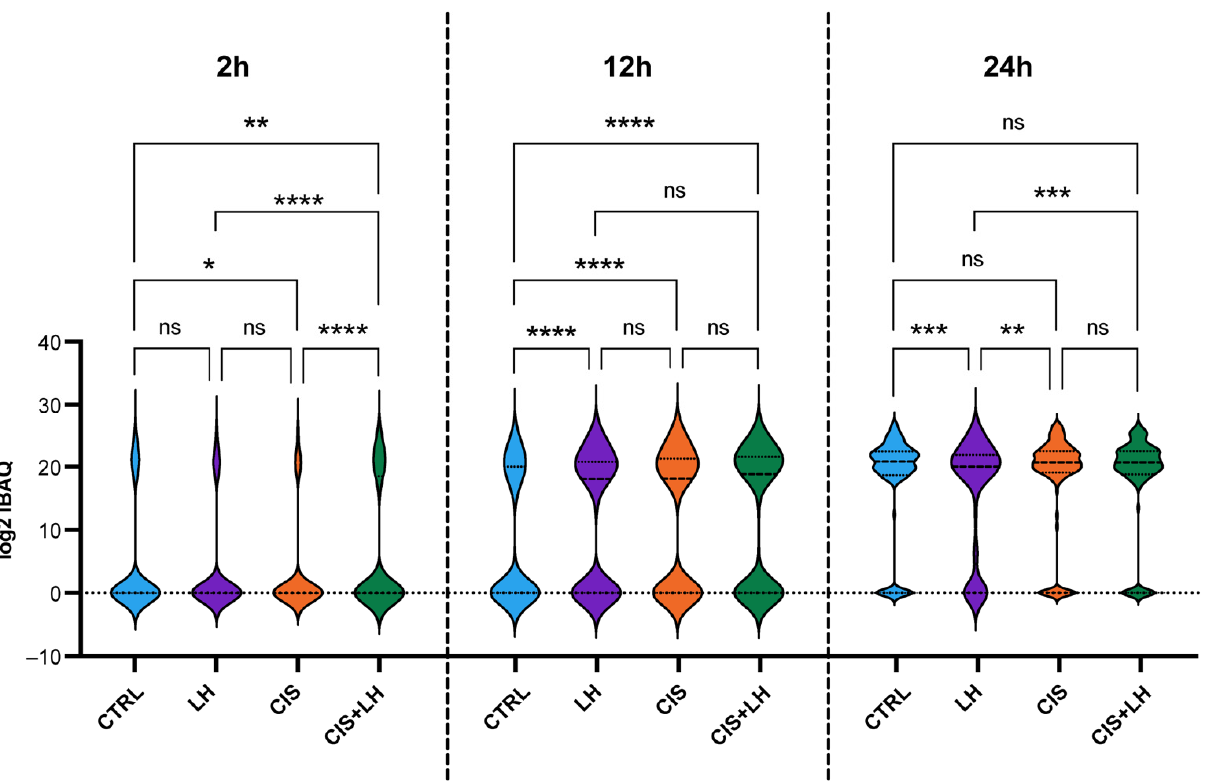
Figure 2. Violin plot representation of the metabolites expressed in each FCM after 2, 12, and 24 h of treatment. Mean log 2 iBAQ values of the 148 secreted metabolites were considered at each time point in the analysis. Statistically significant differences between indicated groups * p < 0.05; ** p < 0.01; *** p < 0.001; **** p < 0.0001.